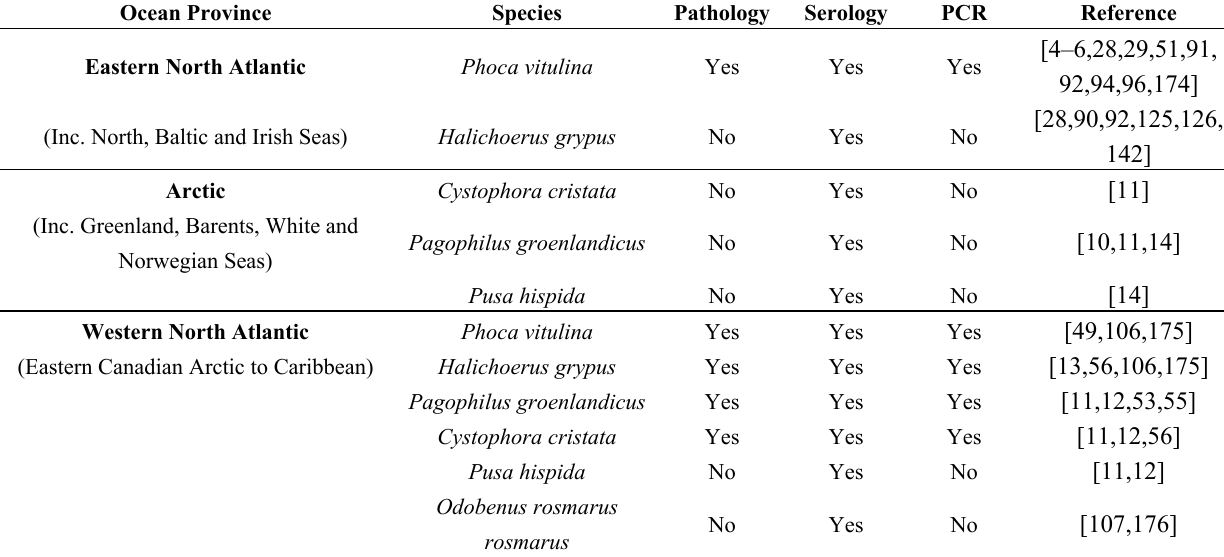
Table 1. Marine Mammals in which PDV has been